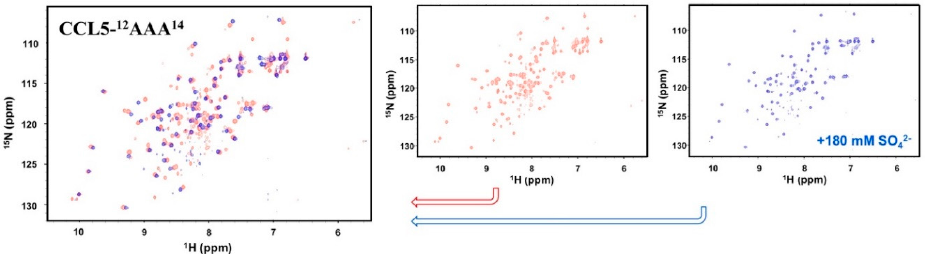
Figure 2. Sulfate titration experiment of CCL5- 12 AAA 14 . 15 N-CCL5- 12 AAA 14 was prepared in 25 mM sodium acetate at pH 3.2 with 150 mM of sodium chloride at 298 K. Ammonium sulfate at a final concentration of 180 mM was added into the NMR sample. The corresponding 1 H, 15 N-HSQC (blue) overlaps with the spectrum before ammonium sulfate titration (red).